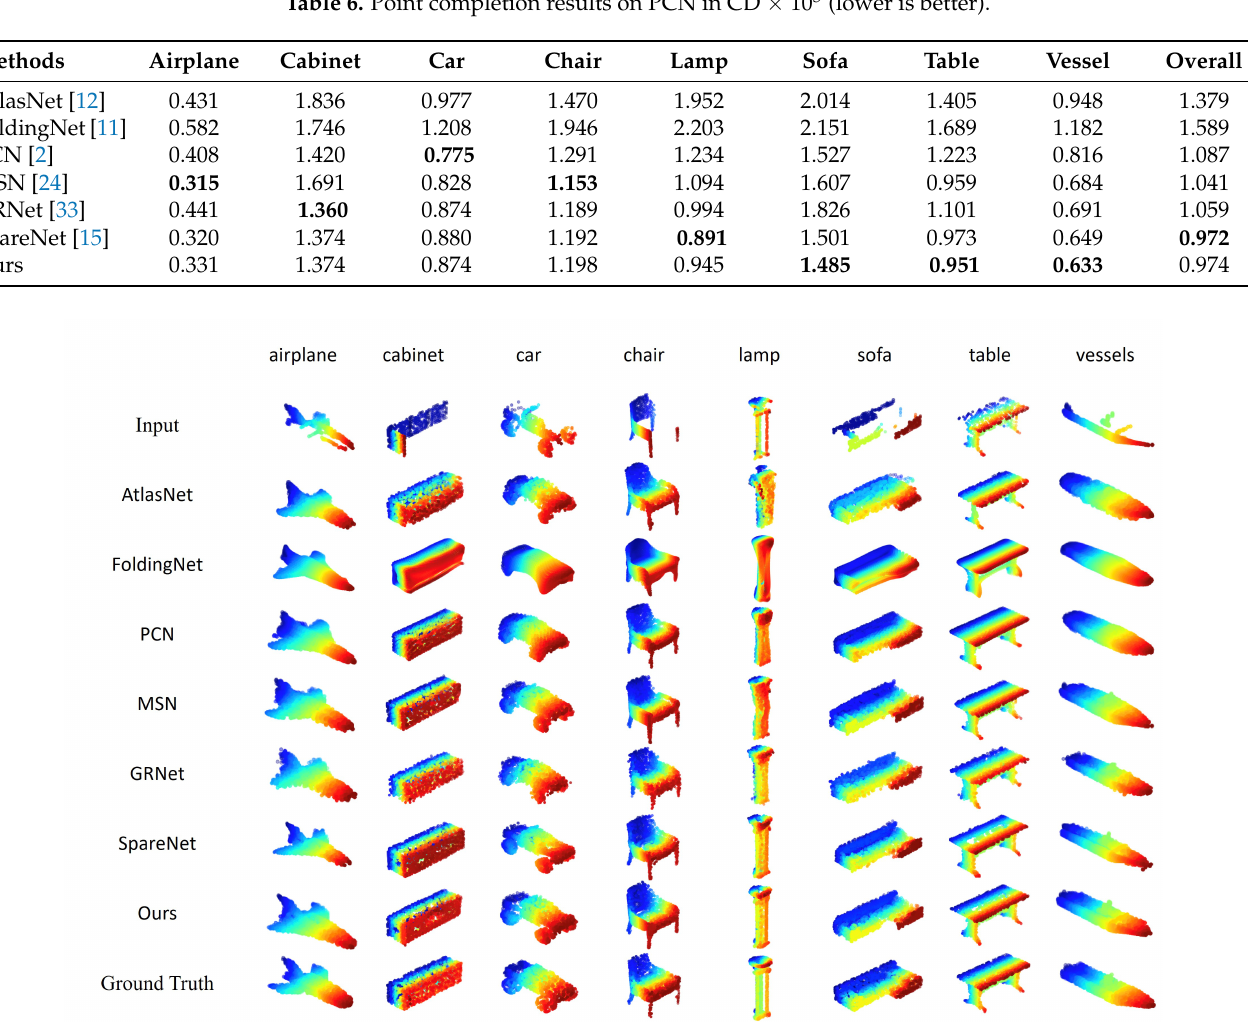
Figure 11. Visual comparison of point cloud completion on the PCN